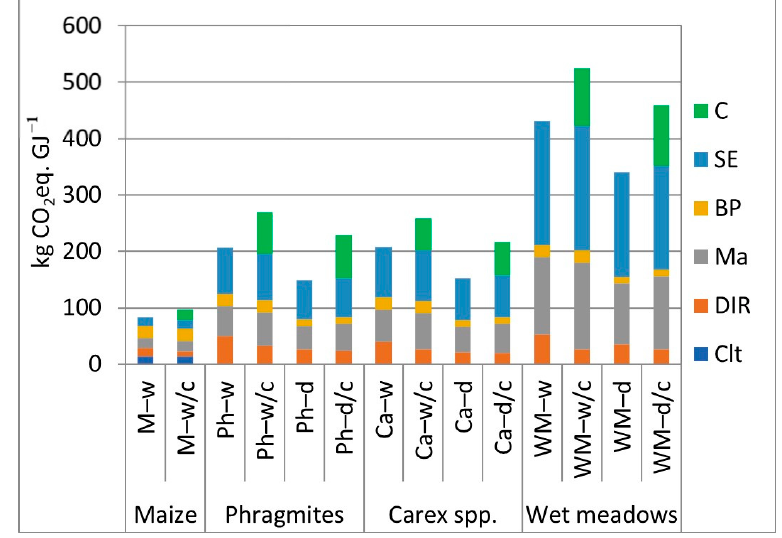
Figure 9. GHG emissions per GJ of produced energy; w—wet fermentation, d—dry fermentation, c—separation and composting of digestate; Clt—emissions from materials for cultivation, DIR—emissions from fuel, Ma—emissions from machinery production, BP—emissions from biogas plant operations, SE—emissions from soil after digestate/compost application, C—emissions from composting. −